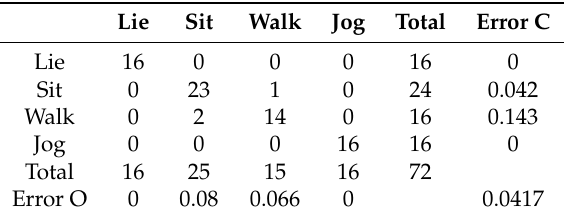
Table 6. Offline confusion table.